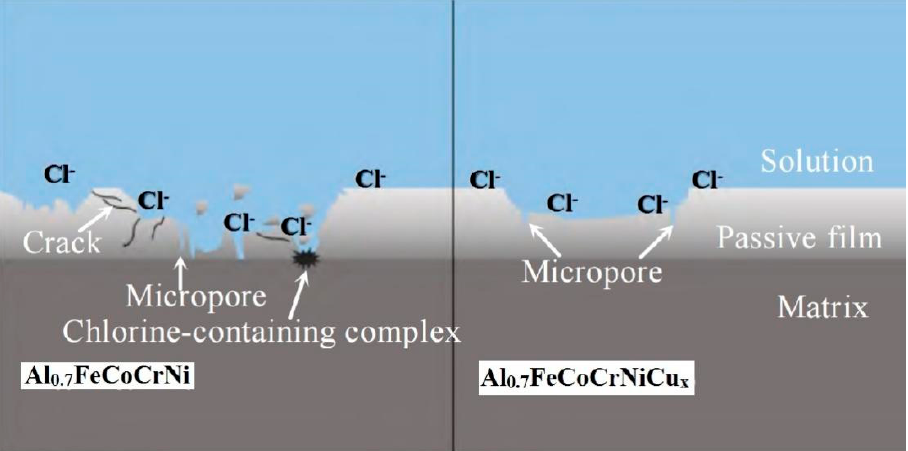
Figure 5. Schematic diagram of corrosion mechanism of the Al 0.7 FeCoCrNiCu x high-entropy alloy.